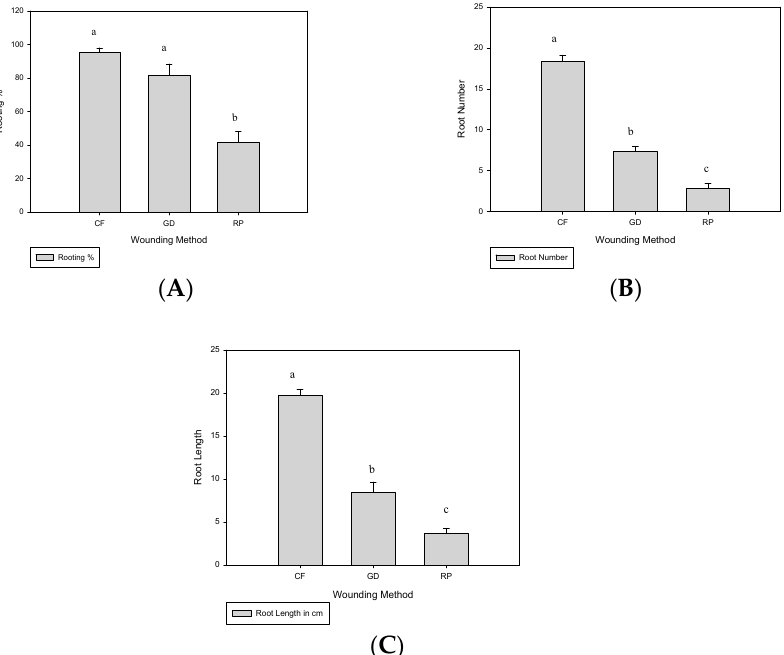
Figure 3. Effect of wounding method on rooting ( A ), root length ( B ), and root number ( C ) of Ficus elastica Roxb. Cutting off (CF): we cut off the aerial roots; Girdling (GD): we used a knife to girdle the aerial roots deep into the xylem; and rectangular shape peeling (RP): we used a knife to incise a rectangular window on the surface of the prop roots of 4 × 2 cm deep into the xylem, then peeled off the skin of the window.